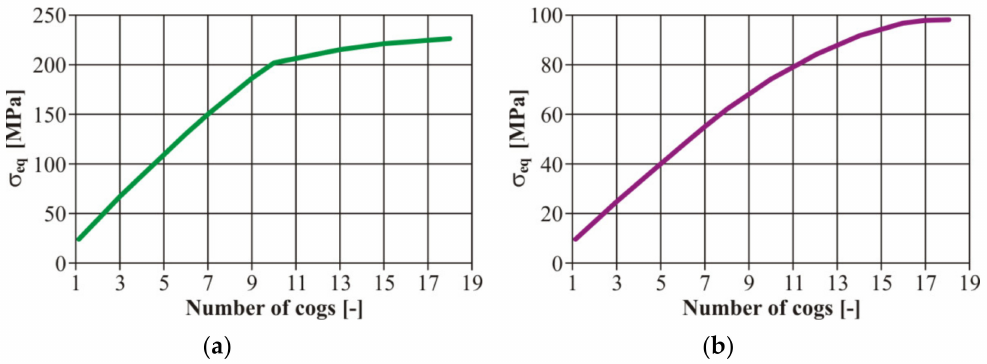
Figure 17. The functions of the equivalent stresses according to the von Mises hypothesis of the tested material: ( a ) by the bending stress with eccentricity e = 1 mm; ( b ) by the torsion stress e = 4 mm.